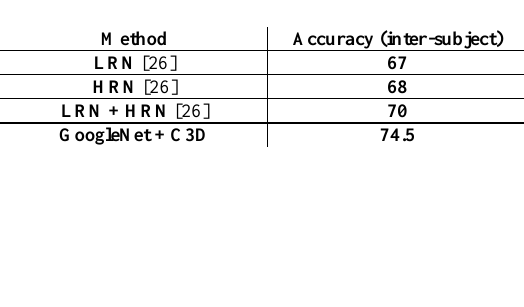
Table 9. Results of different methods on VIVA Hand Gesture